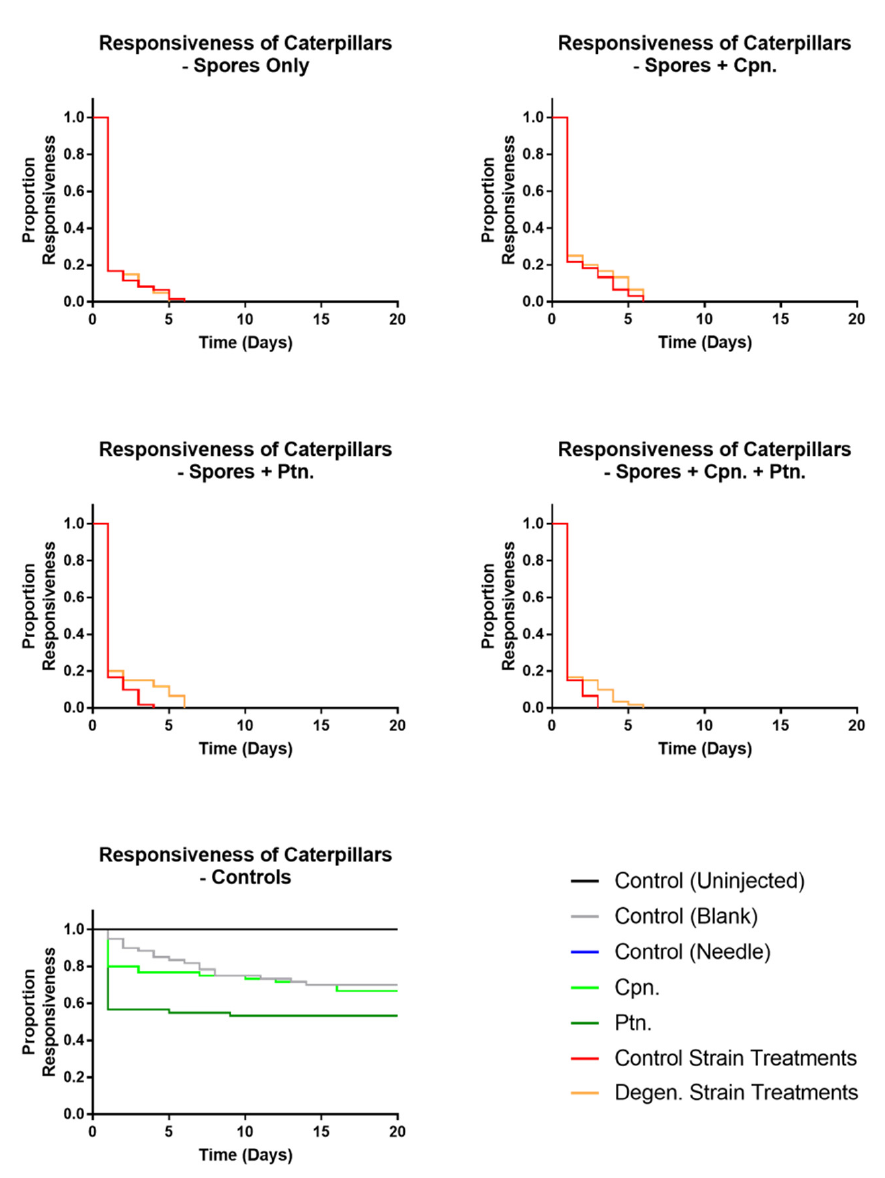
Figure 11. Kaplan Meier plots showing responsiveness observed in Galleria mellonella caterpillars following injections with washed C. militaris conidia, cordycepin and pentostatin. Responsive caterpillars showed self-movement when disturbed indi- vidually using tweezers. Results were recorded on a daily basis over a period of two weeks, following injection of